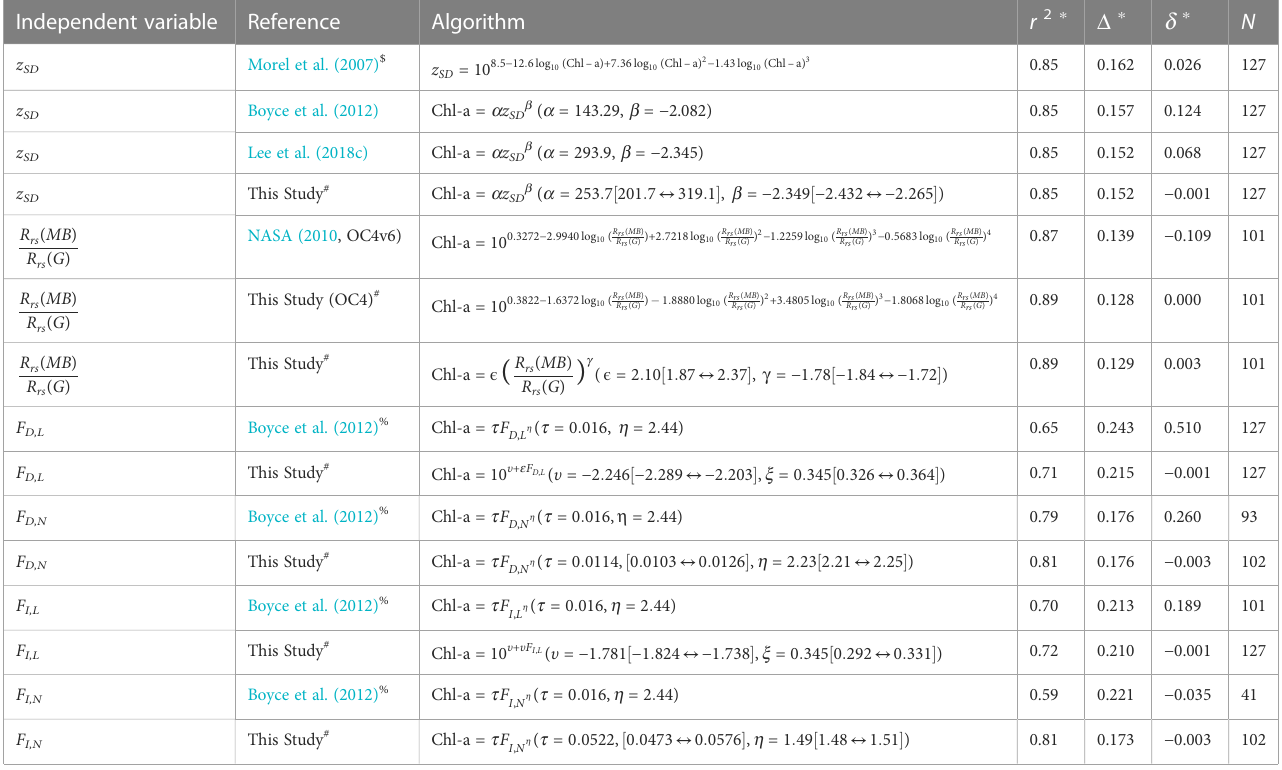
TABLE 2 Algorithms tested to predict Chl-a [mg m − 3 ] (dependent variable) from historic and modern optical measurements (independent variable, models tuned to data, denoted “ This Study ” in Table 2 ). Independent